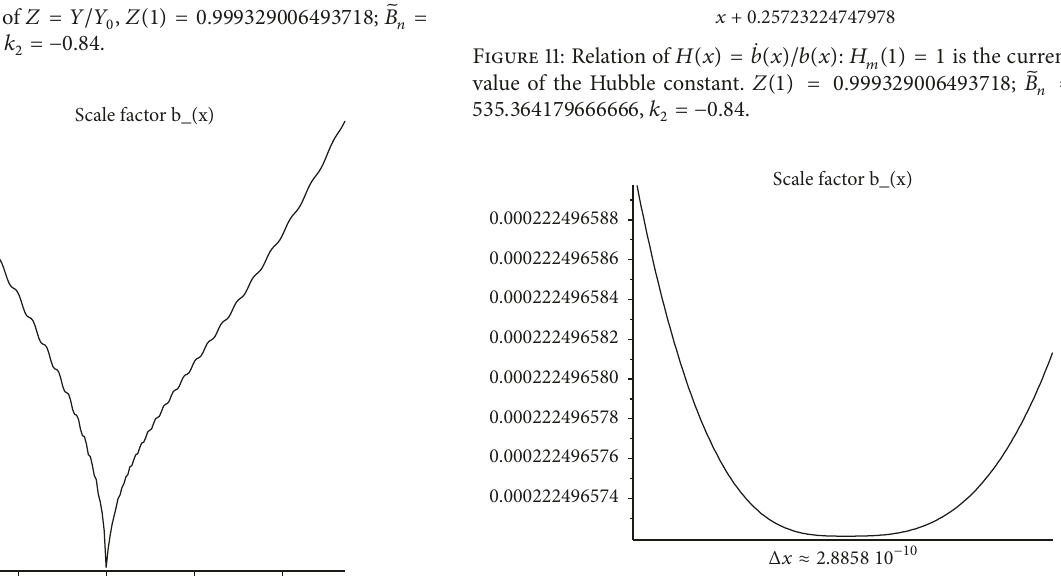
Figure 12: Relation of 𝑏(𝑥) = 𝑎(𝑥)/𝑎 𝑚 , 𝑍(1) = 0.999329006493718.. : Δ𝑥 is relative time interval. ̃𝐵 535.364179666666 , 𝑘